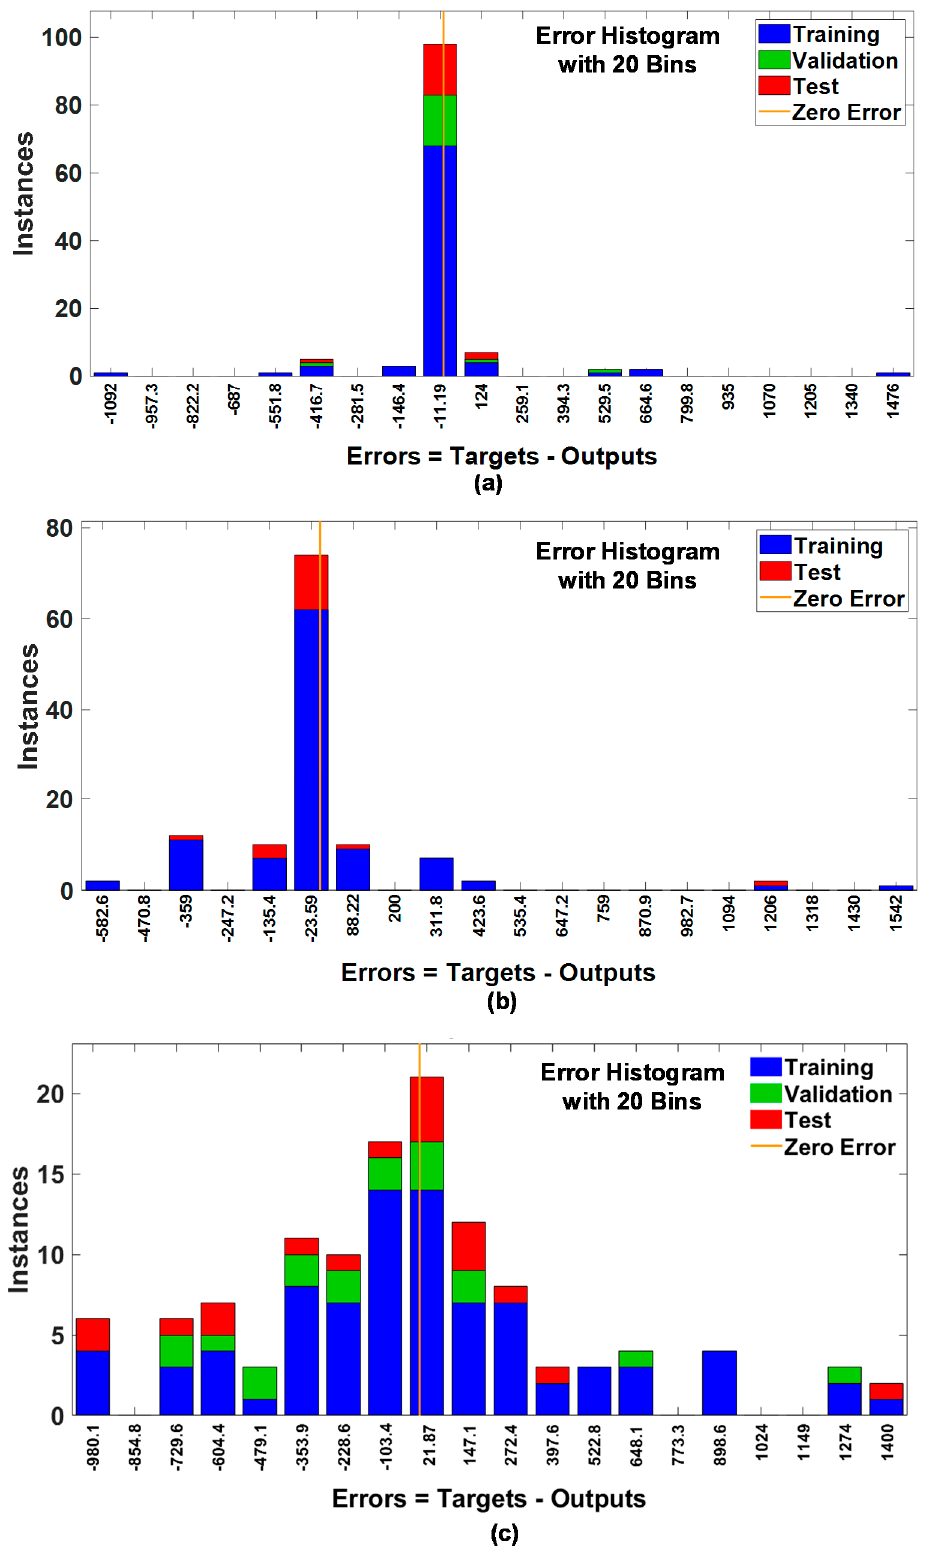
Figure 13. Error histogram plots of ANN with ( a ) Levenberg–Marquardt (LM) algorithm, ( b ) Bayesian Regulation (BR) algorithm, and ( c ) Scaled Conjugate Gradient (SCG) algorithm.